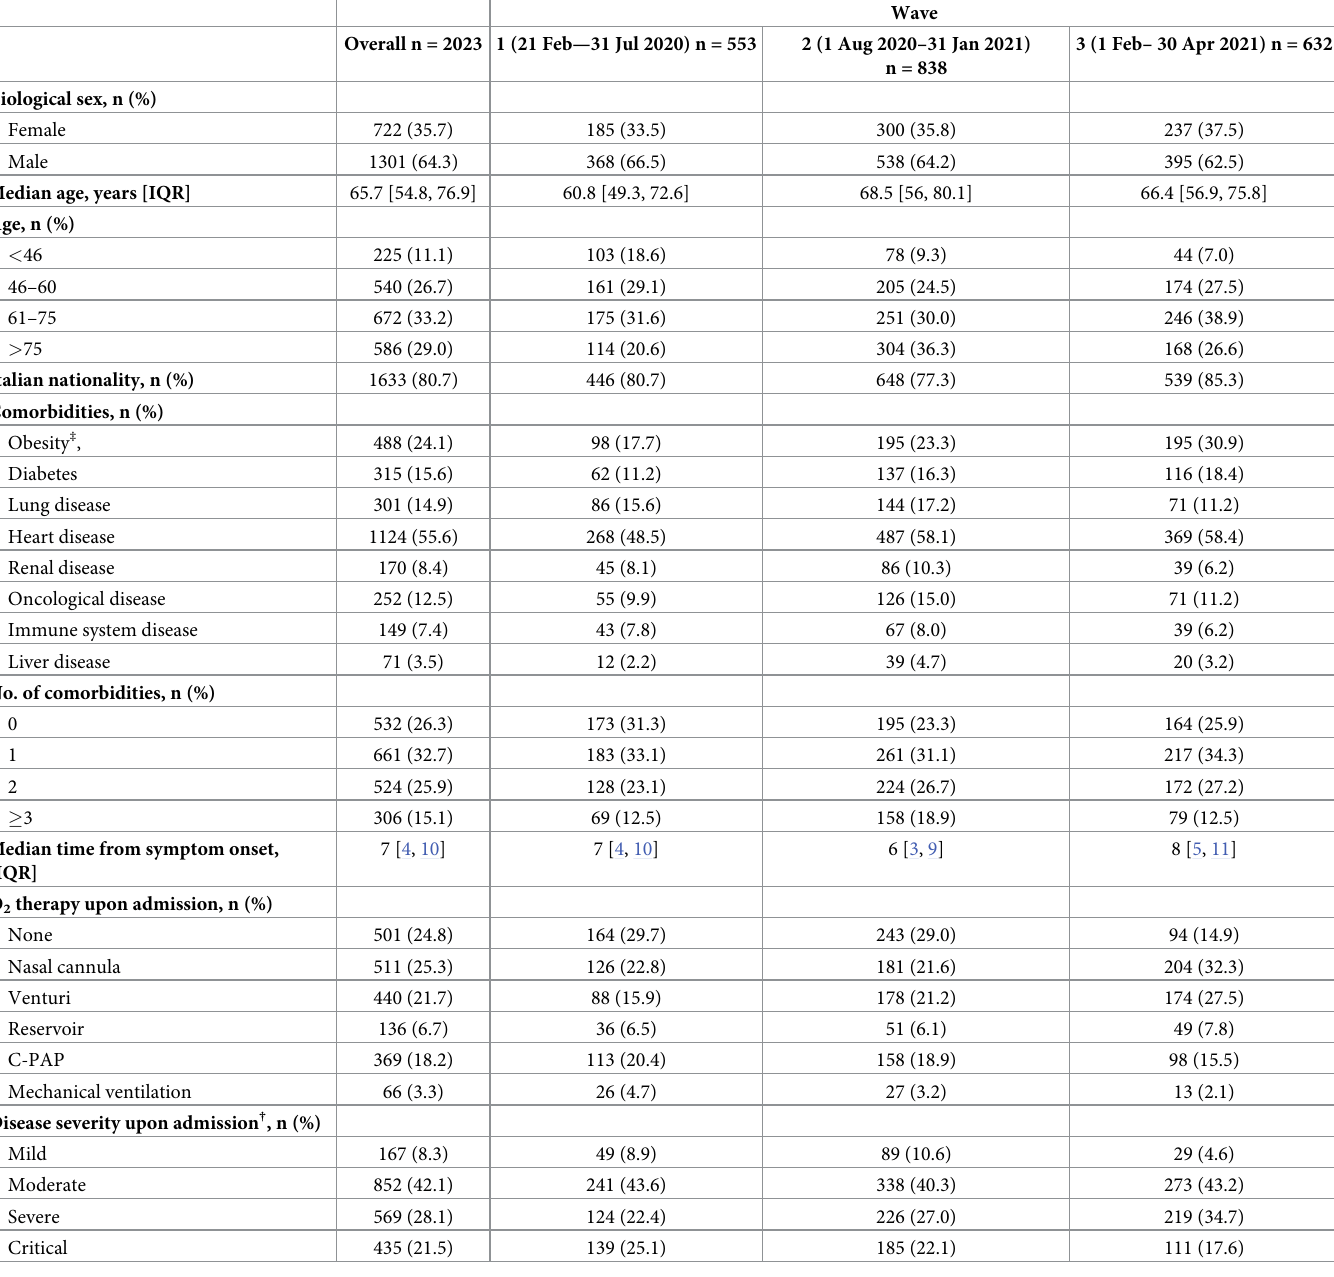
Table 1. Characteristics of the study population as a whole and by period of hospital